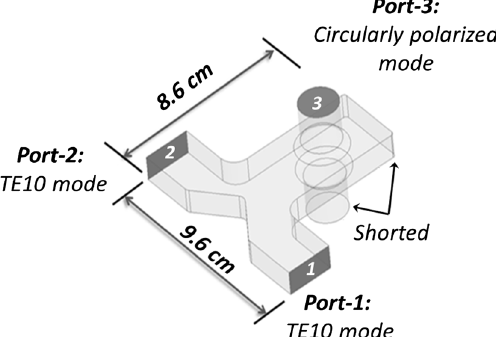
FIG. 1. 3D rendering of an 11.424 GHz, x-band, rf polarizer with physical ports and waveguide types labeled accordingly.